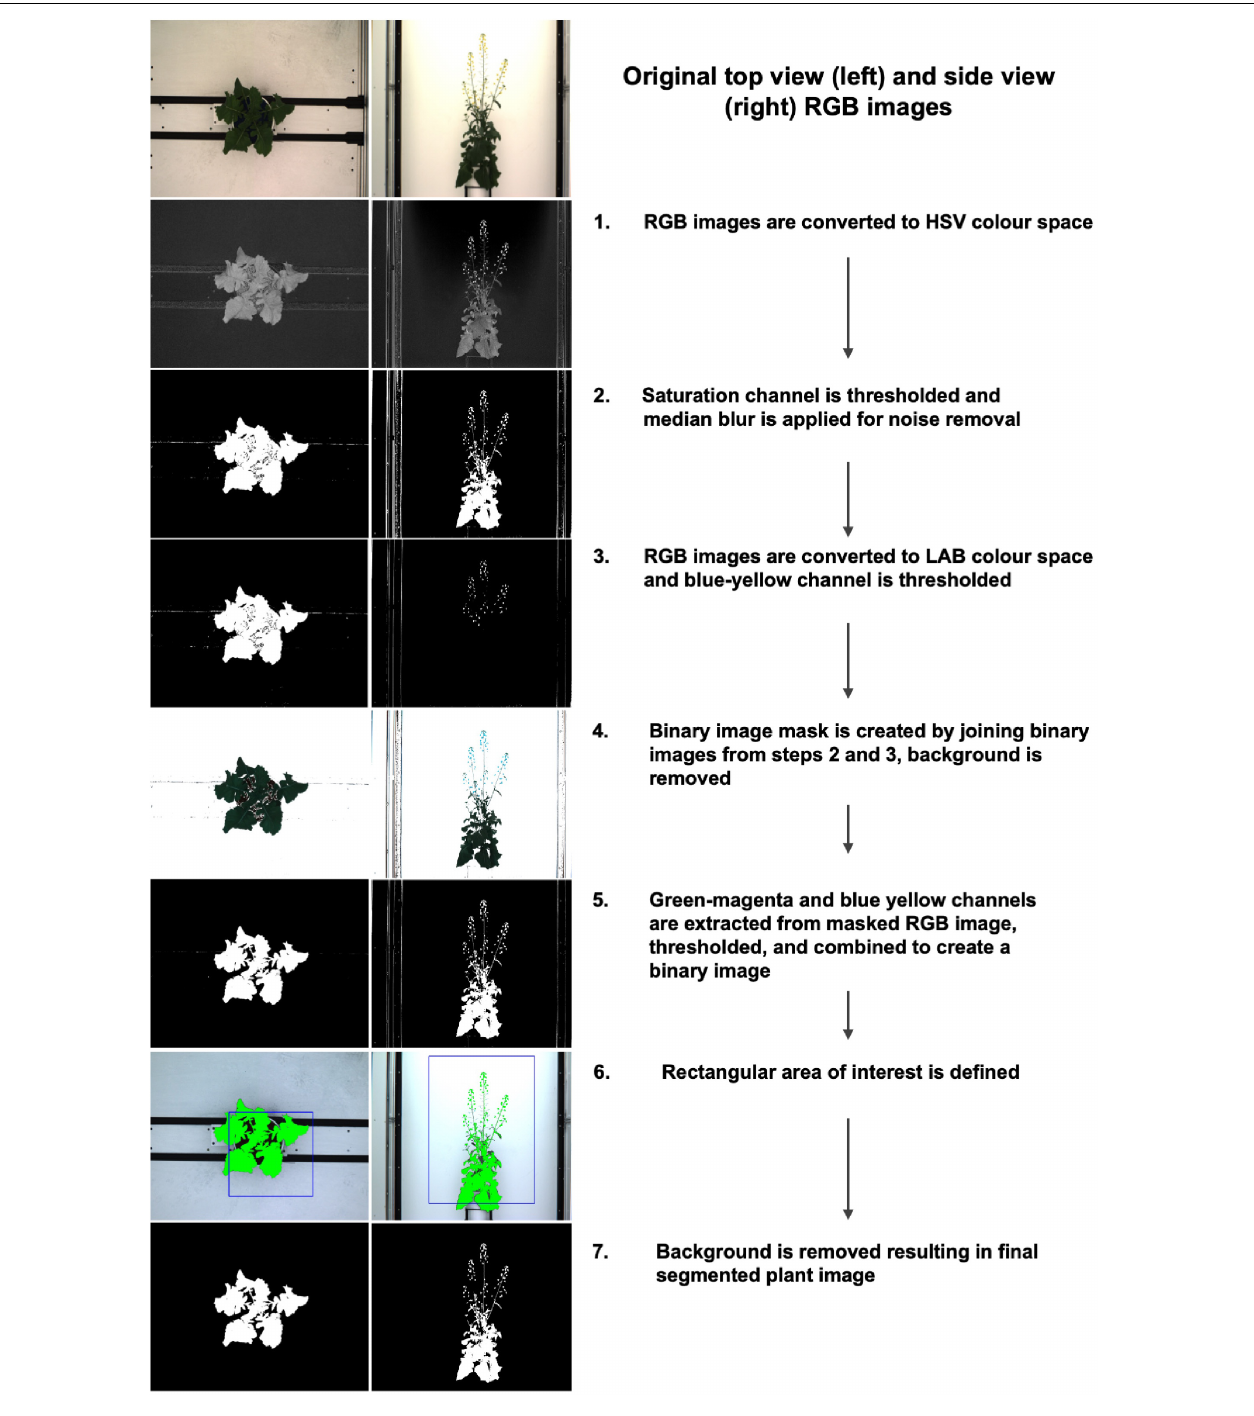
FIGURE 2 | Image segmentation workflow and corresponding examples of top view (left) and side view (right) images.